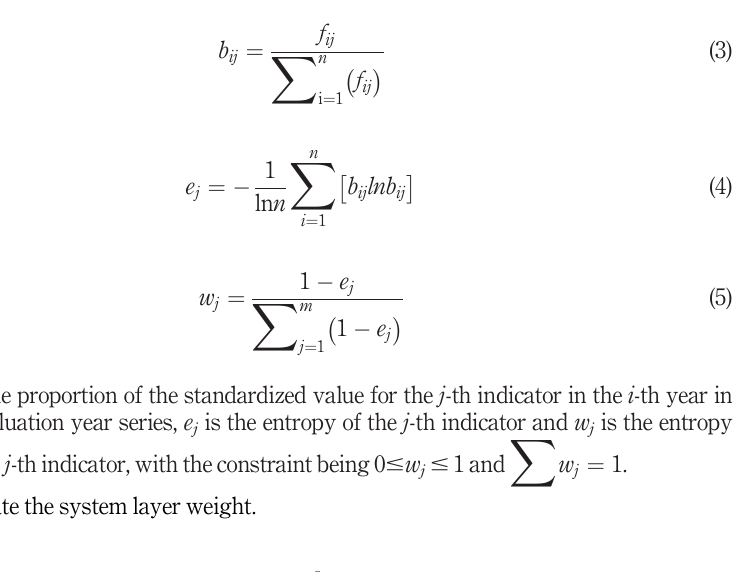
is the entropy j # 1 and j